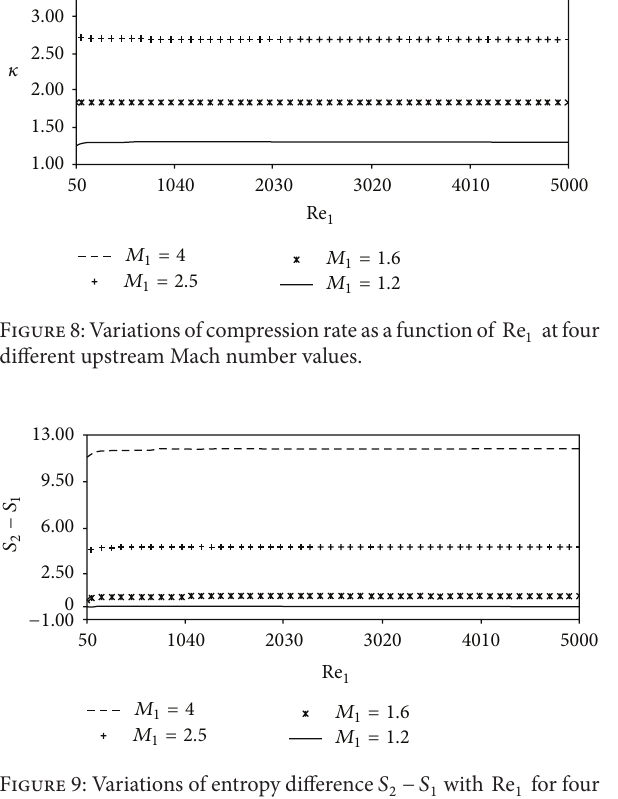
Figure 9: Variations of entropy difference 𝑆 2 − 𝑆 1 with Re 1 for four different values of 𝑀 1